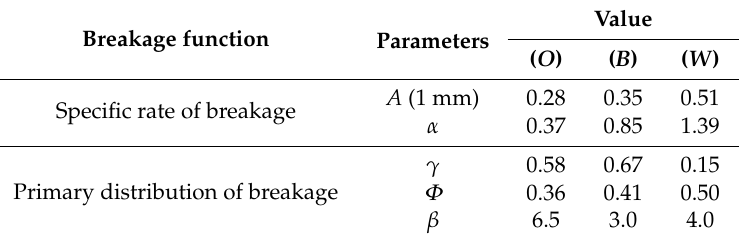
Table 5. Breakage parameters obtained by